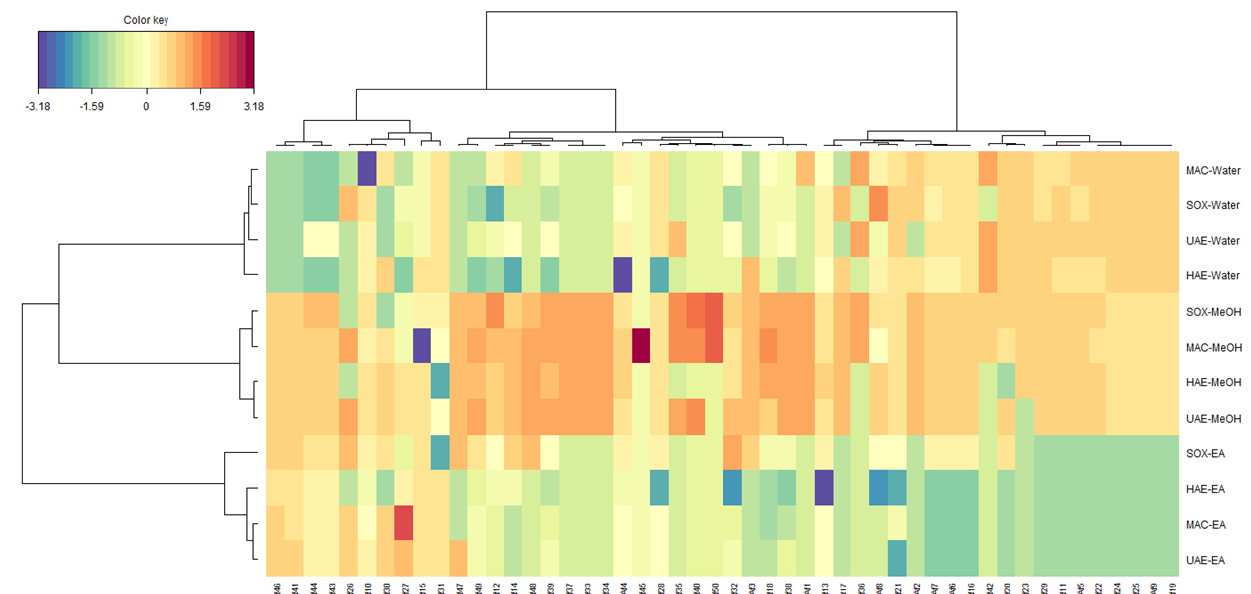
Figure 2. Clustered image maps on the Secondary metabolites in Alcea fasciculiflora extracts. Red colour: Highest concentration. Blue Colour: Lowest concentration. For compounds numbers refer to Table 1.